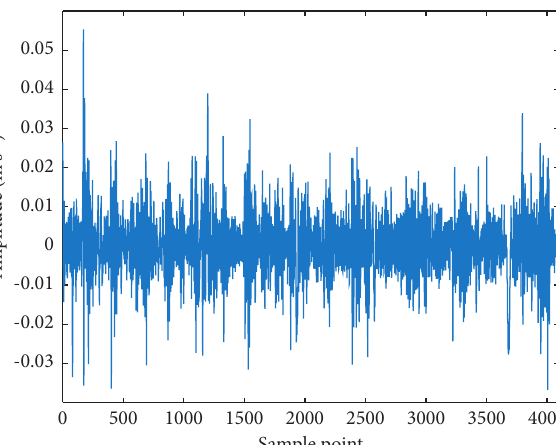
Figure 11: The time-domain trend of the employed data collected from ER-12K deep groove ball bearing with outer ring